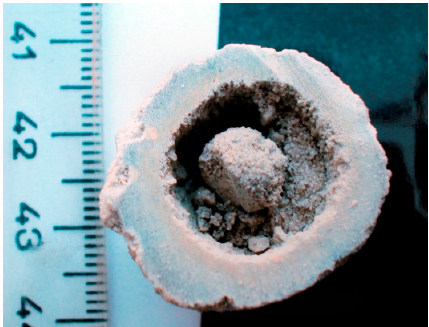
Figure 4. Cross-section through a hollow siderite sphere from the Herja ore deposit which contains inside free siderite rhombohedron crystals and a smaller siderite sphere partially cut during the sawing of the sample (from [32] (p. 134) with written permission from the editor).